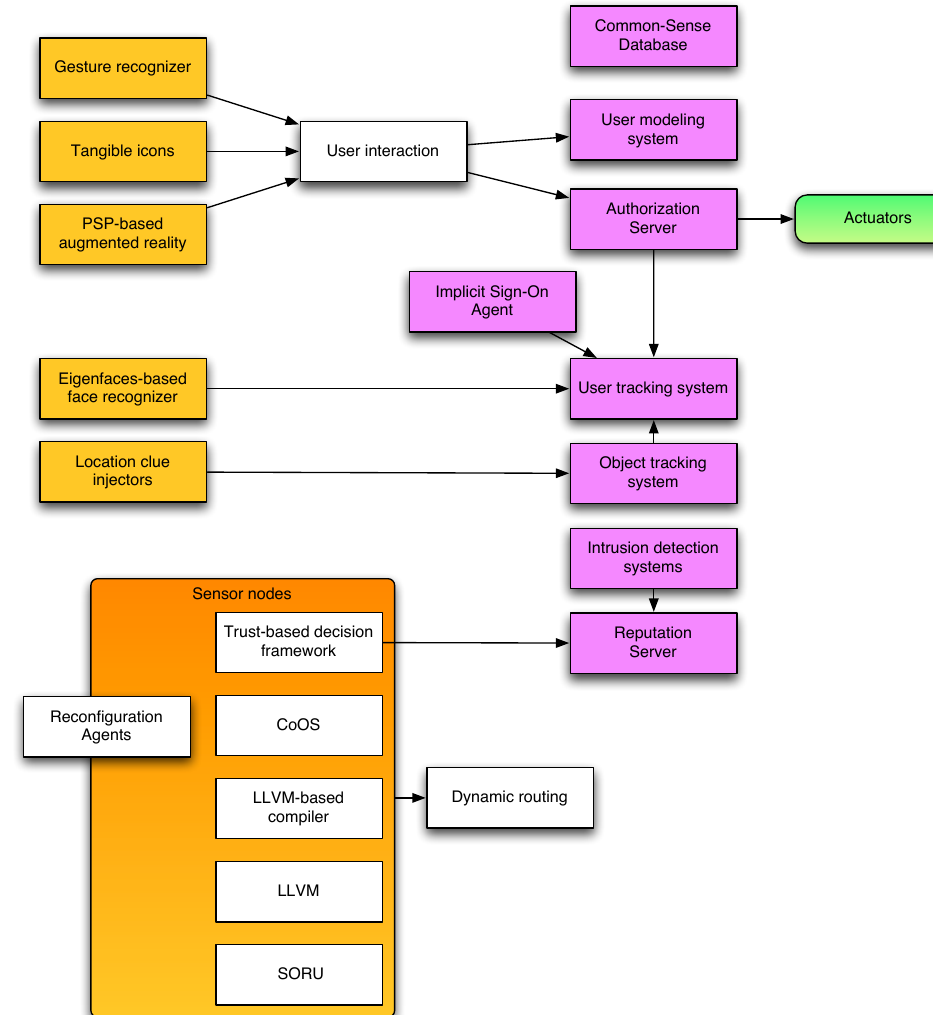
Figure 2. Main components in the security